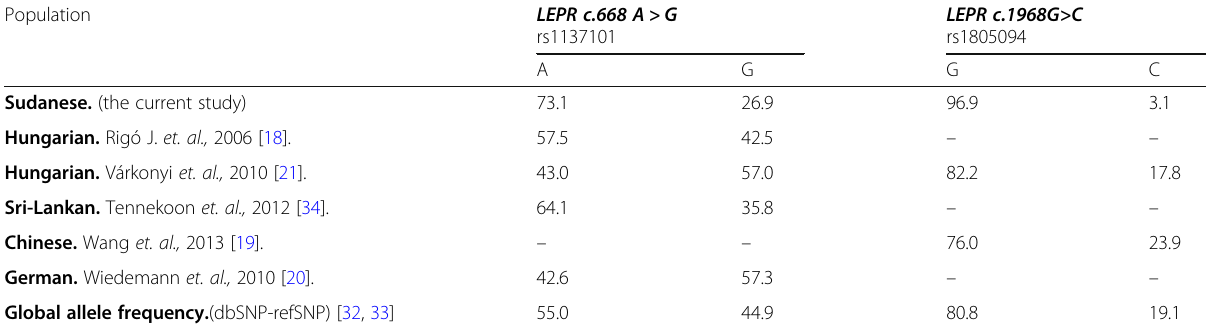
Table 3 Comparison of allele frequency of the LEPR c.668 A > G and LEPR c.1968G>C polymorphisms in the Sudanese sample with world population Population